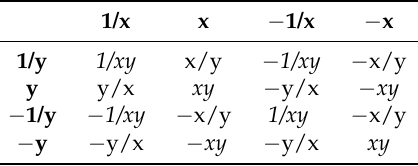
Table 4. All the possible combinations for multiplying and dividing two Posit numbers: all the cells in italics correspond to the same LUT entry, and all the remaining ones correspond to another LUT